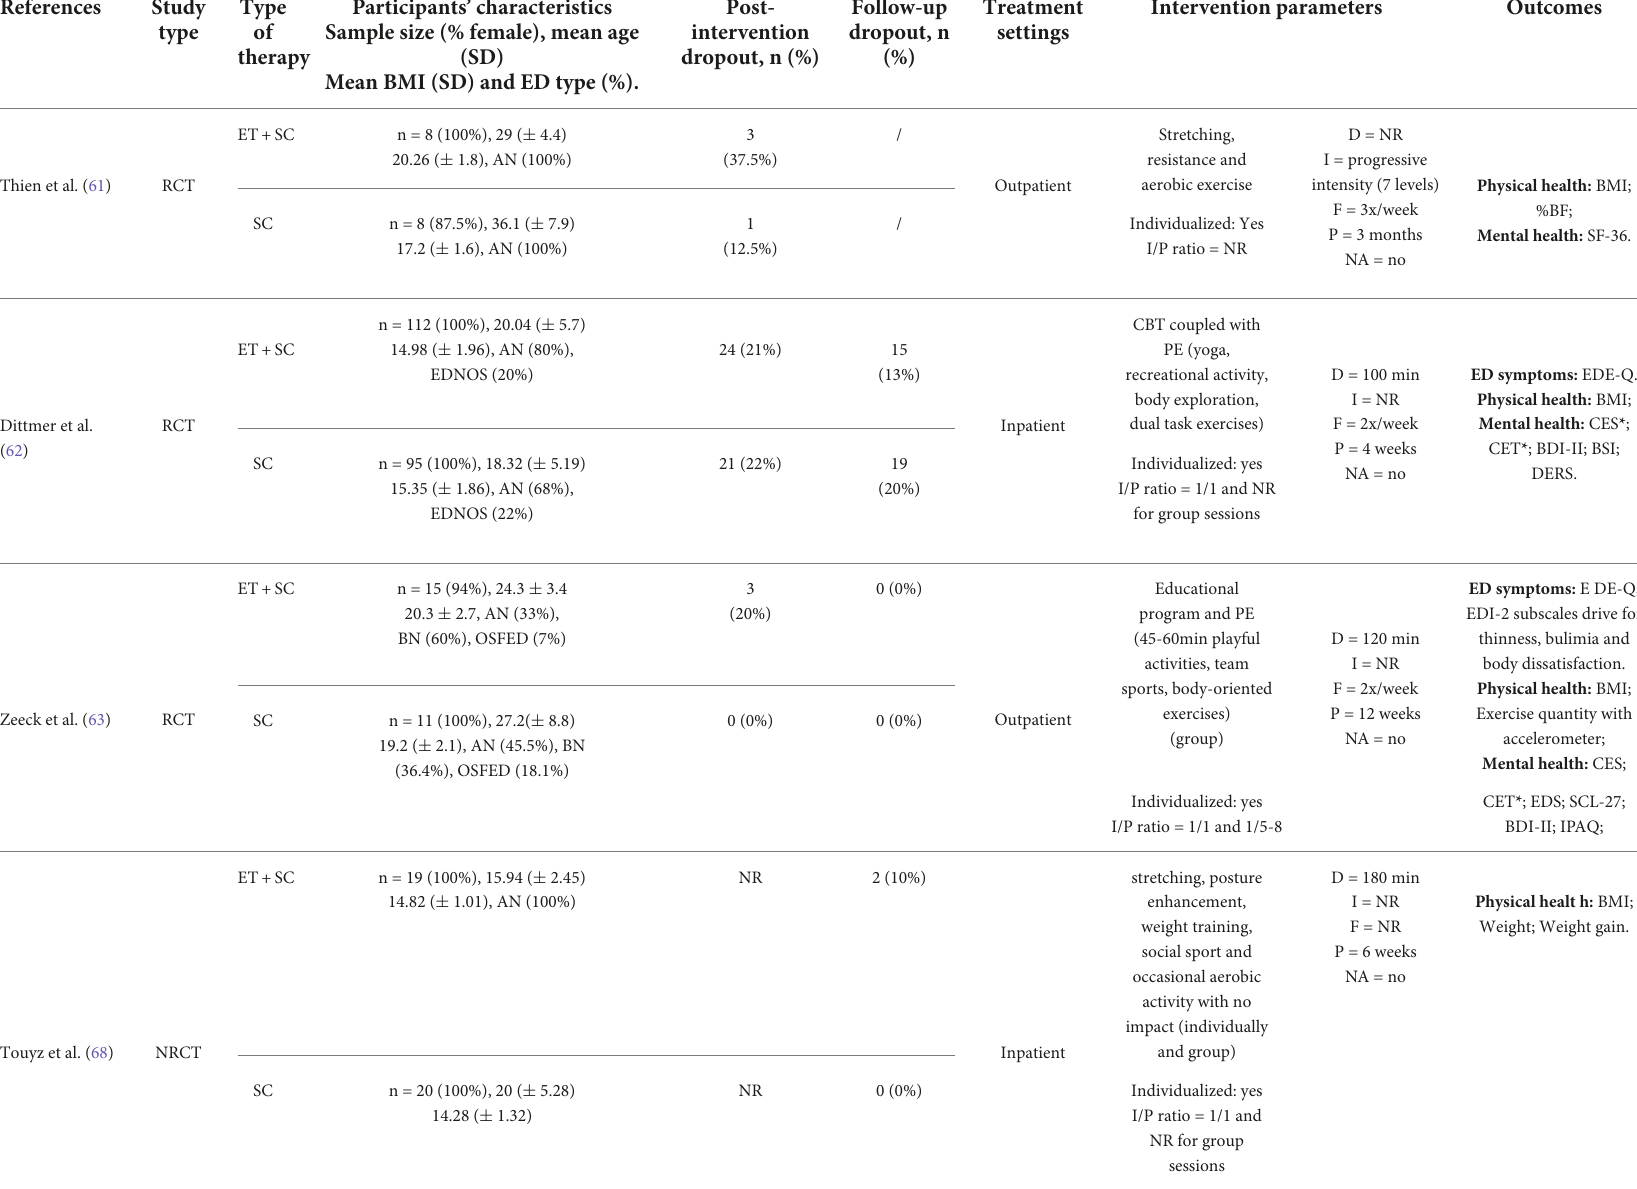
TABLE 6 Characteristics and main results of studies (RCT, NRCT, UT) conducted on effects of combined physical exercise interventions in patients with